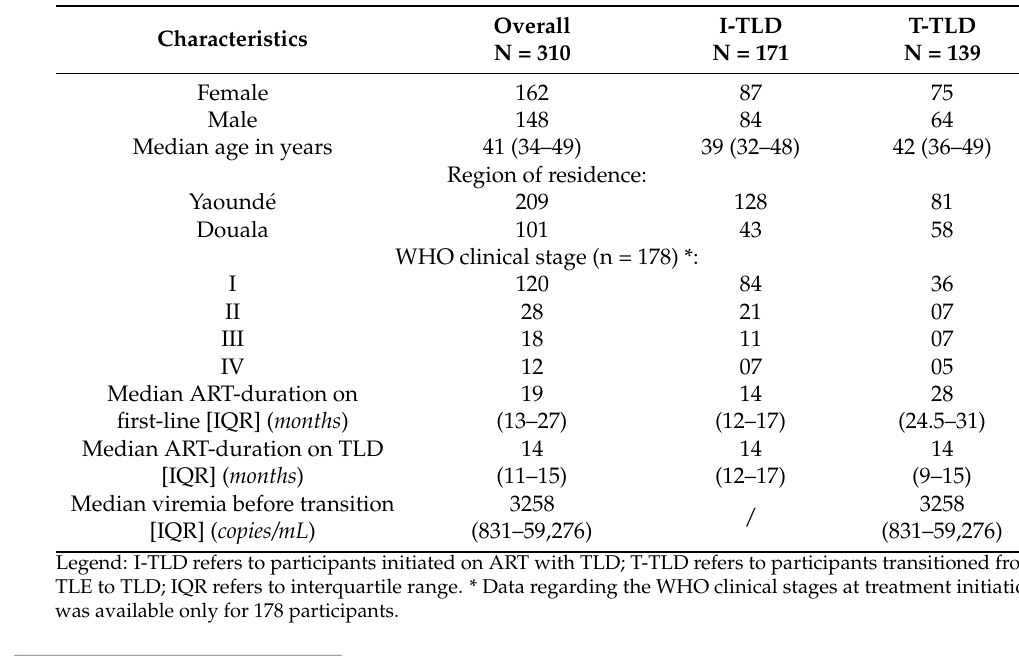
Table 1. Baseline characteristics of study participants.